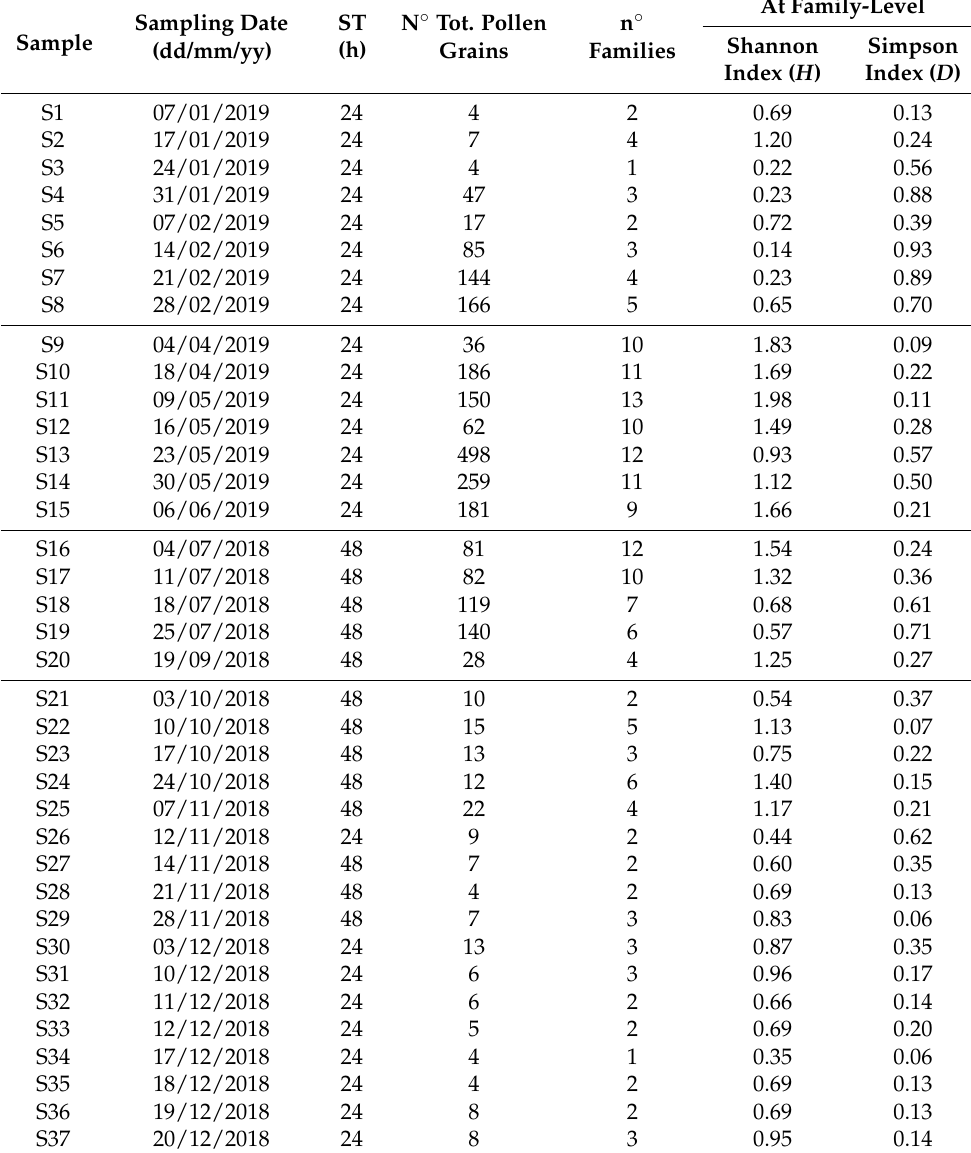
Table 1. Sampling Date (day/month/year) and duration (expressed in h) of Sampling Time (ST) interval for the 37 samples collected at Brindisi. Samples were collected in different seasons (winter: S1–S8; spring: S9–S15; summer: S16–S20; autumn: S21–S37). The sampling time started at 00.00 UTC of the Sampling Date. N ◦ Tot. Pollen Grains shows for each sample the number of pollen grains associated with the families monitored at Brindisi according to AIA protocol, in addition to the number of pollen grains due to Others and Unclassified . The n ◦ Families show the number of pollen families per sample monitored at Brindisi according to AIA protocol. The Shannon ( H ) and Simpson ( D ) index values at the family level are also reported for each sample. Samples are listed according to the sampling month by taking S1 collected on 7 January 2019 as the first sample.